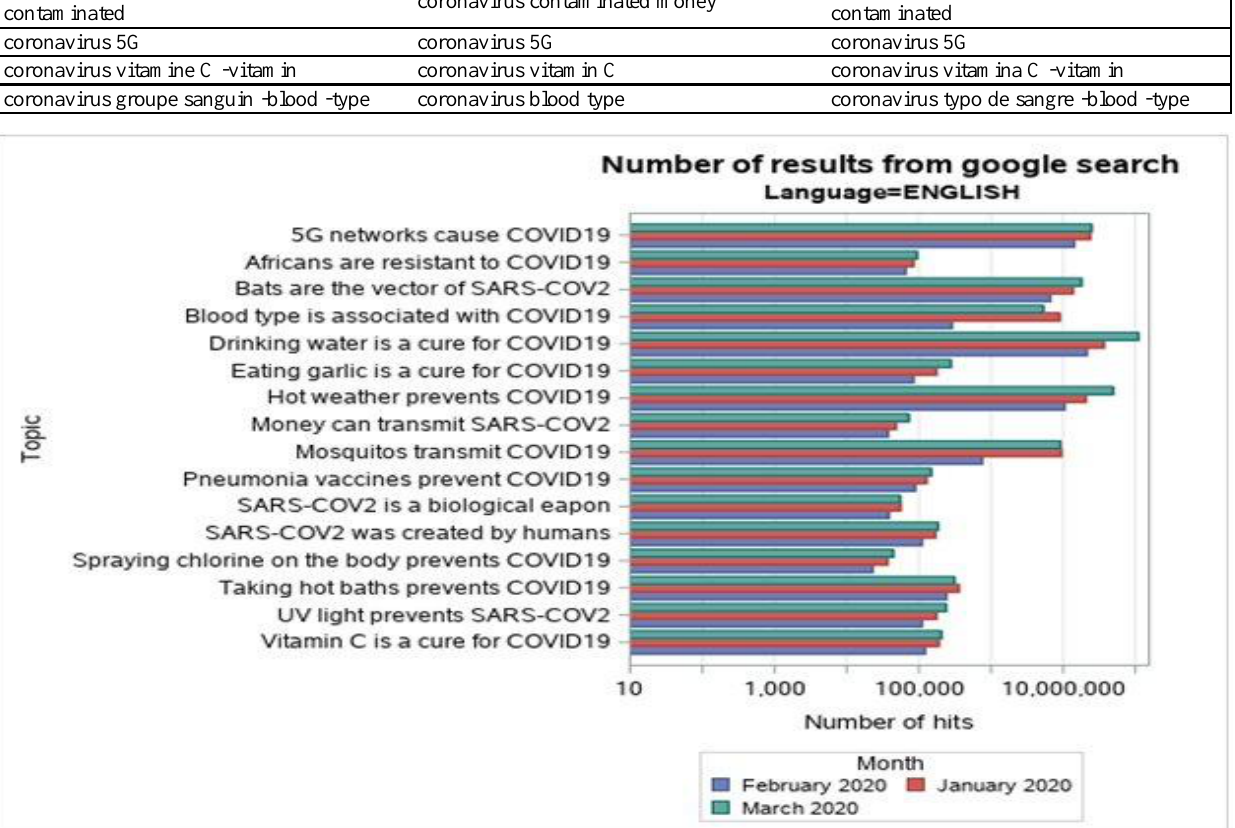
Figure 1: Number of results from Google search in English. UV: Ultraviolet